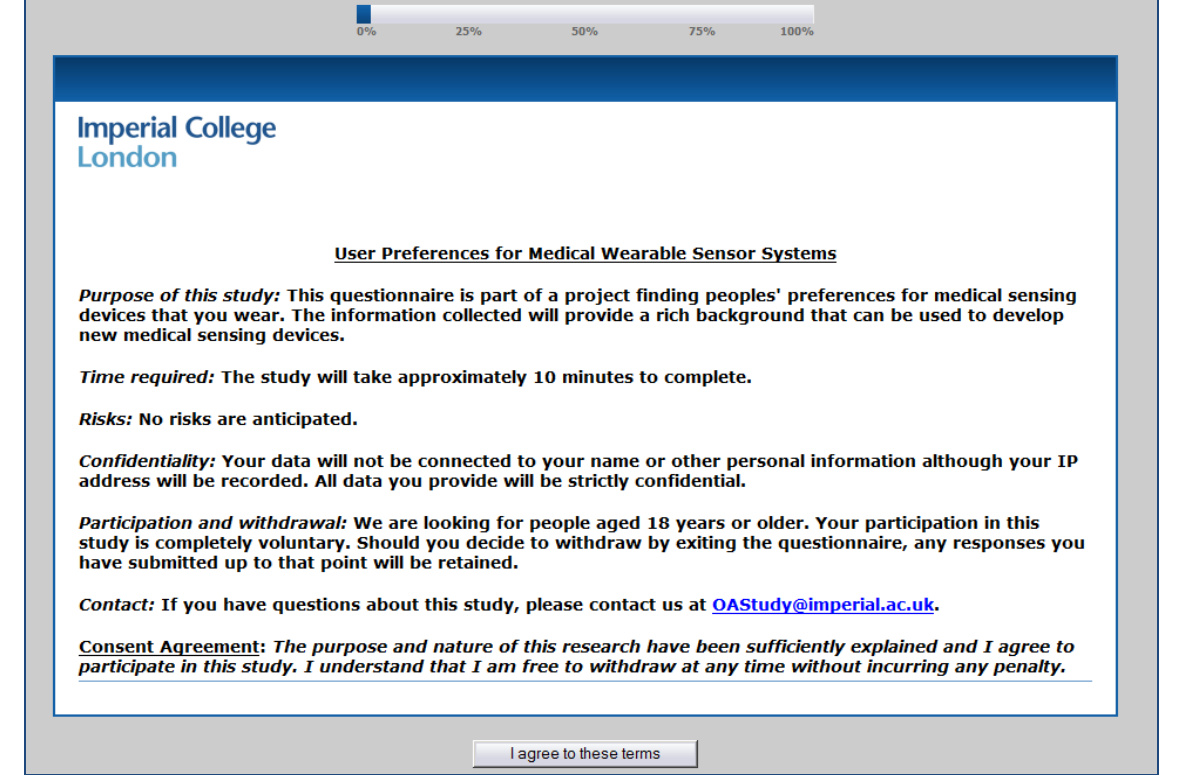
Figure 1. Screenshot of the opening page of the online